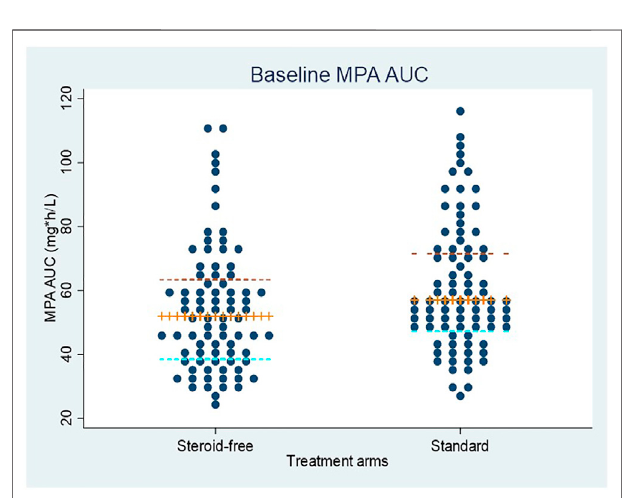
FIGURE 2 | MPA AUC measurements in relation to time after transplantation. Blue dots represent measurements in patients allocated to the steroid-free arm and red dots measurements in patients allocated to the standard arm.